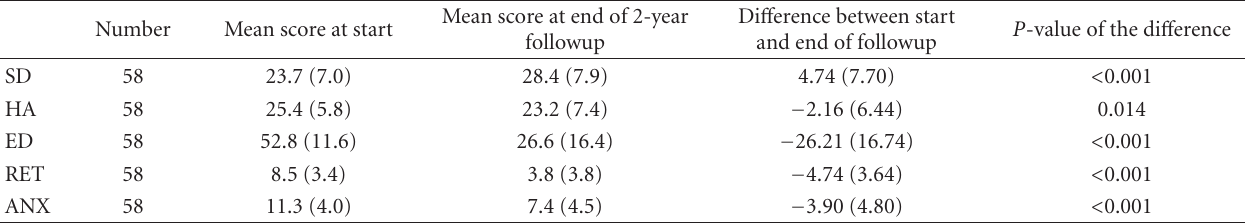
Table 1: Mean scores (standard deviation between brackets) of SD, HA, ED, RET, and ANX at the start and after two years, and their di ff erences, in 58 patients with depression.